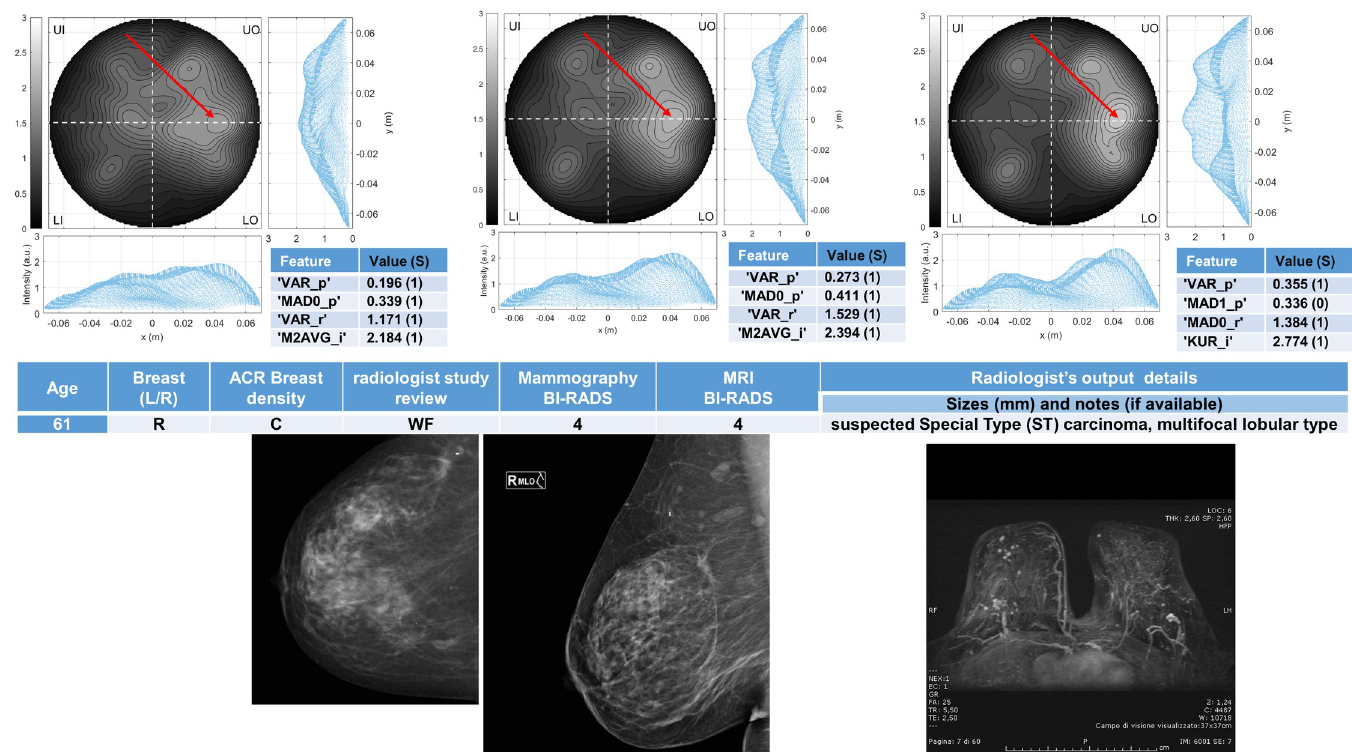
Fig 7. The radiologist study review “WF” for this heterogeneously dense (ACR C) breast has been obtained with the support of mammography and MRI images given in the bottom row, giving as output the presence of a suspected Special Type (ST) carcinoma, multifocal lobular type. The Mammography BI-RADS is 4 and the Magnetic Resonance Imaging (MRI) BI-RADS is 4. The final assessment is malignant lesion. Microwave images, normalized to unitary average of the intensity, are given in the top row for three different conductivity weighting (from left to right: 0.3 S/m, 0.4 S/m and 0.5 S/m, respectively). X and Y are given in meters; intensity is in arbitrary units. All microwave images show a non-homogeneous behavior, with a main peak indicated by the red arrows. From the binary score S (given in the inserted tables) we note that the number of occurrences of “1” is four when σ = 0.3 S/m, four when σ = 0.4 S/m and three when σ = 0.5 S/m. The proposed rule-of-thumb classifies this breast as